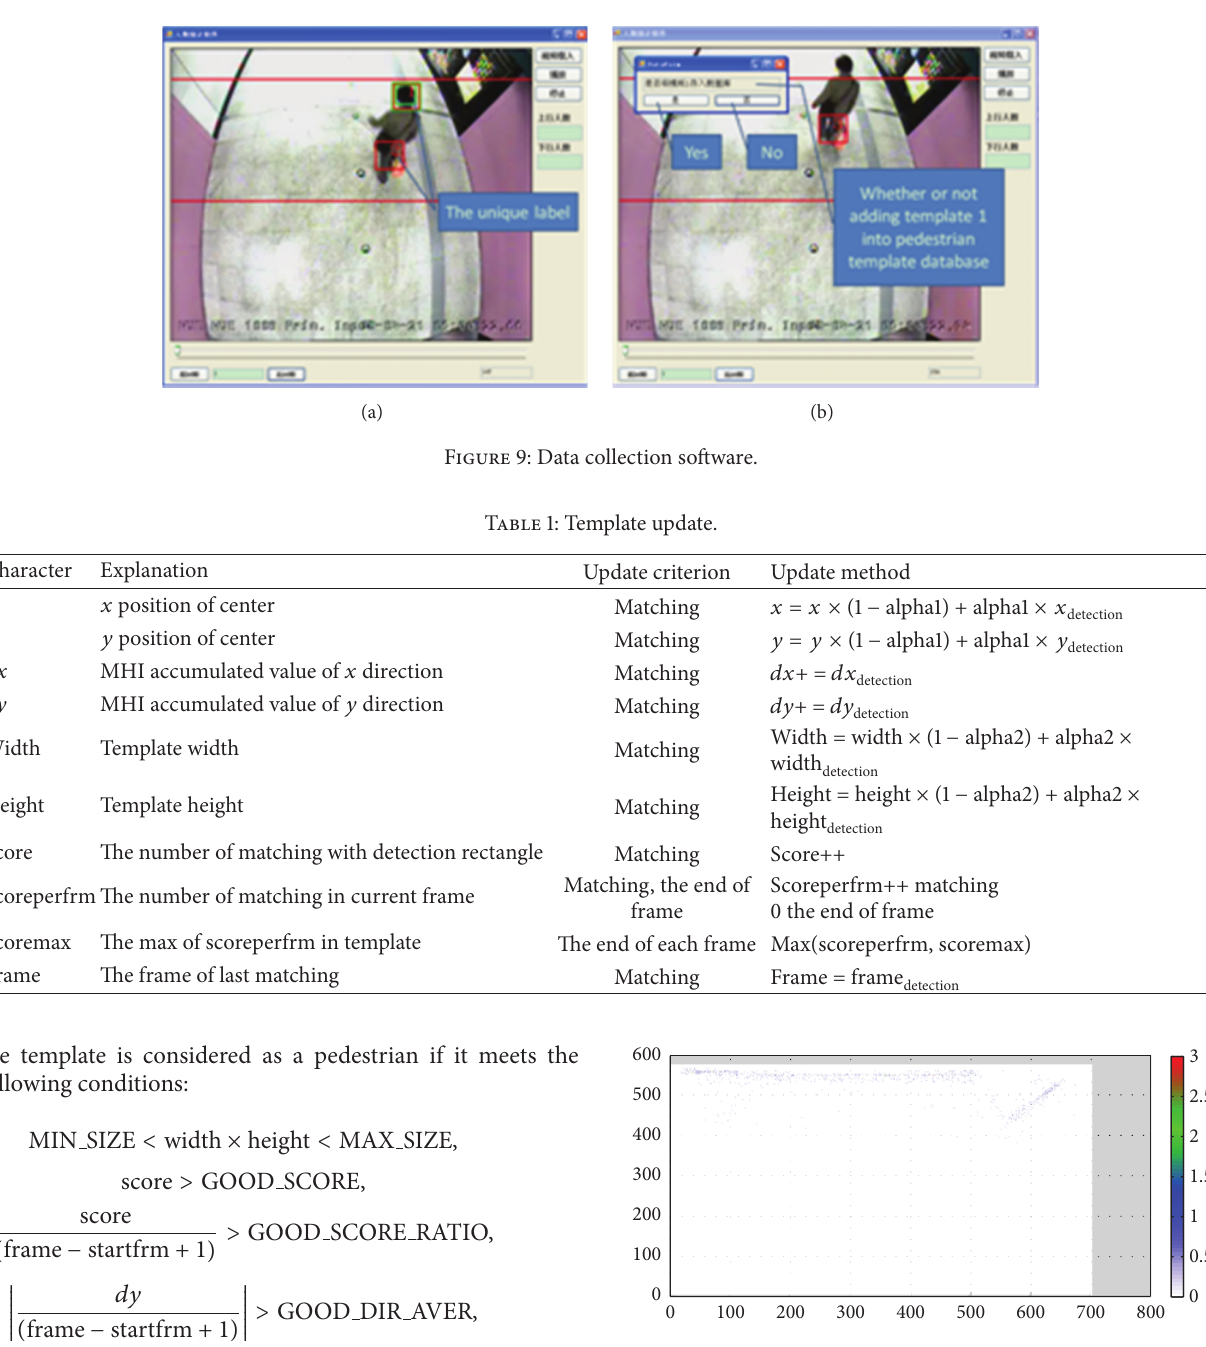
Figure 10: The scatter gram of the frequency of the template